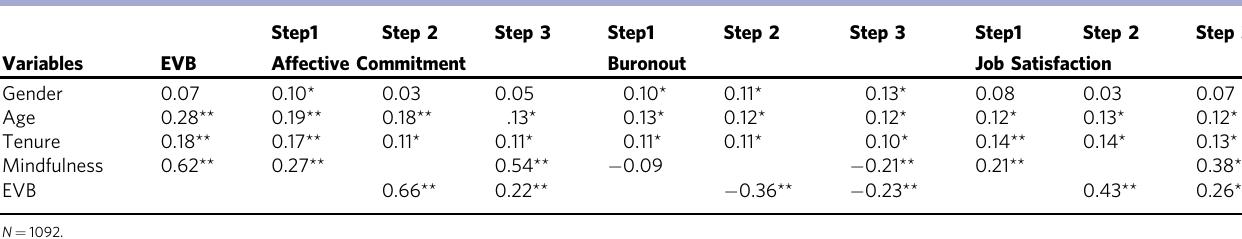
Table 4 Hierarchcal regression